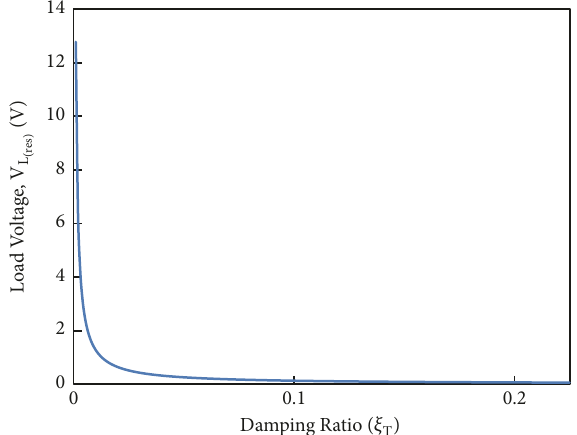
Figure 13: Load voltage at resonance vs. total damping ratio 𝜉 T of the